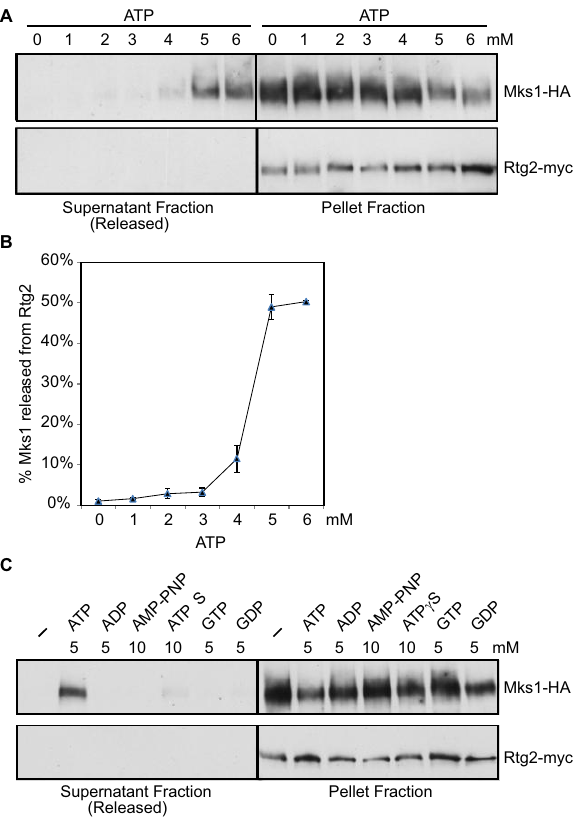
Figure 2. The effect of ATP titration on Mks1 release from Rtg2. ( A ) Immunopurified Rtg2-myc-Mks1-HA complex from RBY915 cells co-expressing Rtg2-myc and Mks1-HA was incubated with titrating levels of ATP, and the presence of Rtg2-myc and Mks1-HA in the pellet and supernatant (released) fractions were determined by Western-blotting. ( B ) Quantitative analysis of the amount of Mks1 released from Rtg2 in the presence of ATP. The result was the average of two independent experiments. ( C ) The effect of 5 mM ADP, GTP or GDP and 10 mM AMP-PNP or ATP (cid:74) S on the interaction between Rtg2 and